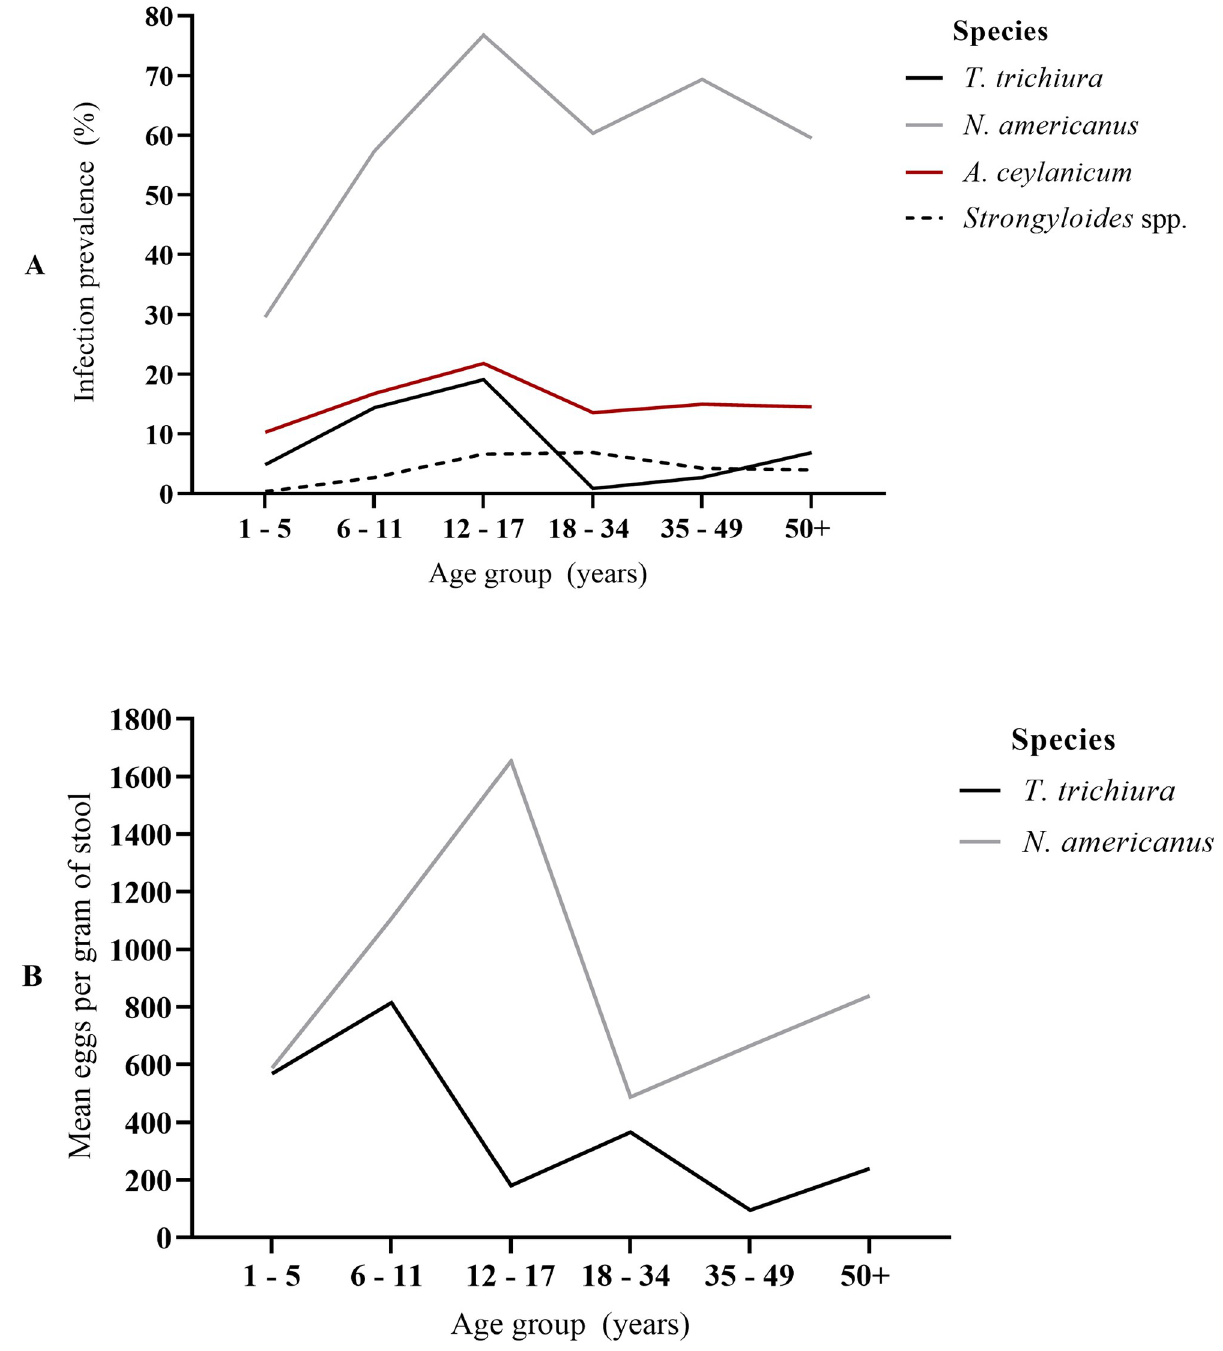
Fig 1. Age- infection profiles by STH species. (A) Prevalence, (B) Intensity as measured by mean eggs per gram of stool. Exact values including 95% confidence intervals and standard deviations are shown in Table 2 (prevalence) and Table E in S1 Text (intensity). A . lumbricoides infections excluded due to few positive